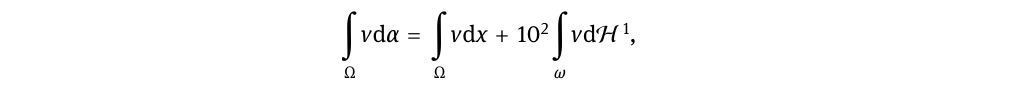
Figure 4: Example 1 ( fi xed f , varying α ) . The rows correspond to u h , ∣ ∣ u h 2 ∇ , and p and 0.5. The third column corresponds to α with jump discontinuity. In all cases, we observe that the gradient constraints are active in the entire region, except on a set of measure zero. Moreover, discontinuity in p in the last column is clearly visible.